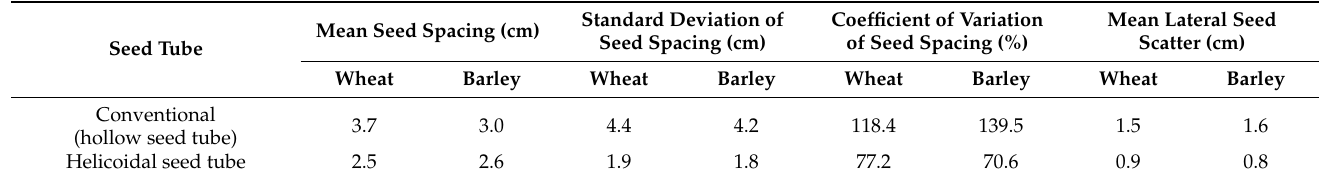
Table 9. The effect of seed tubes on the seed’s distribution accuracy in field trials.